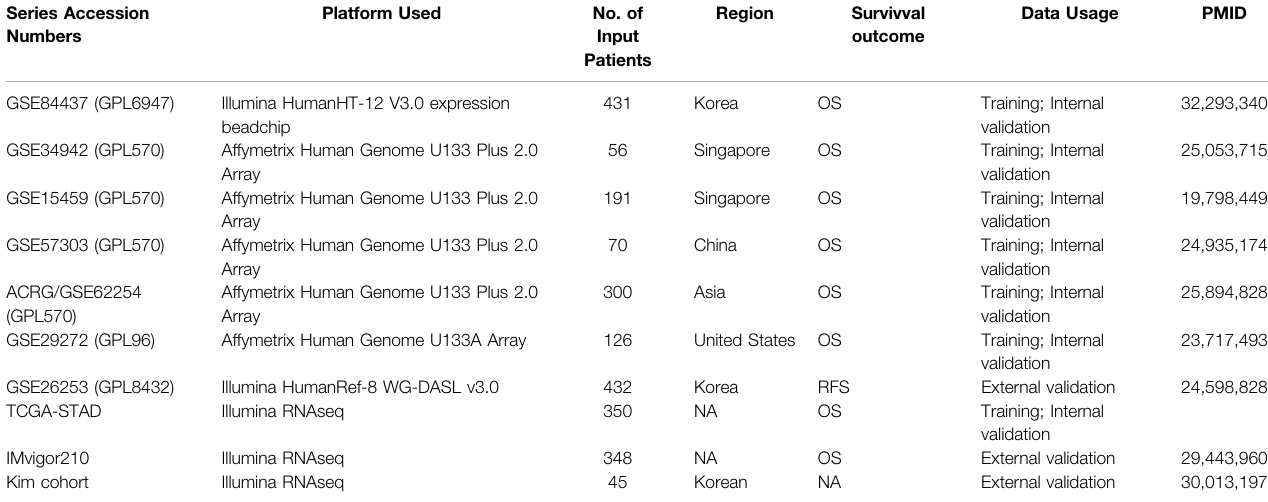
TABLE 1 | Basic information of series used in this